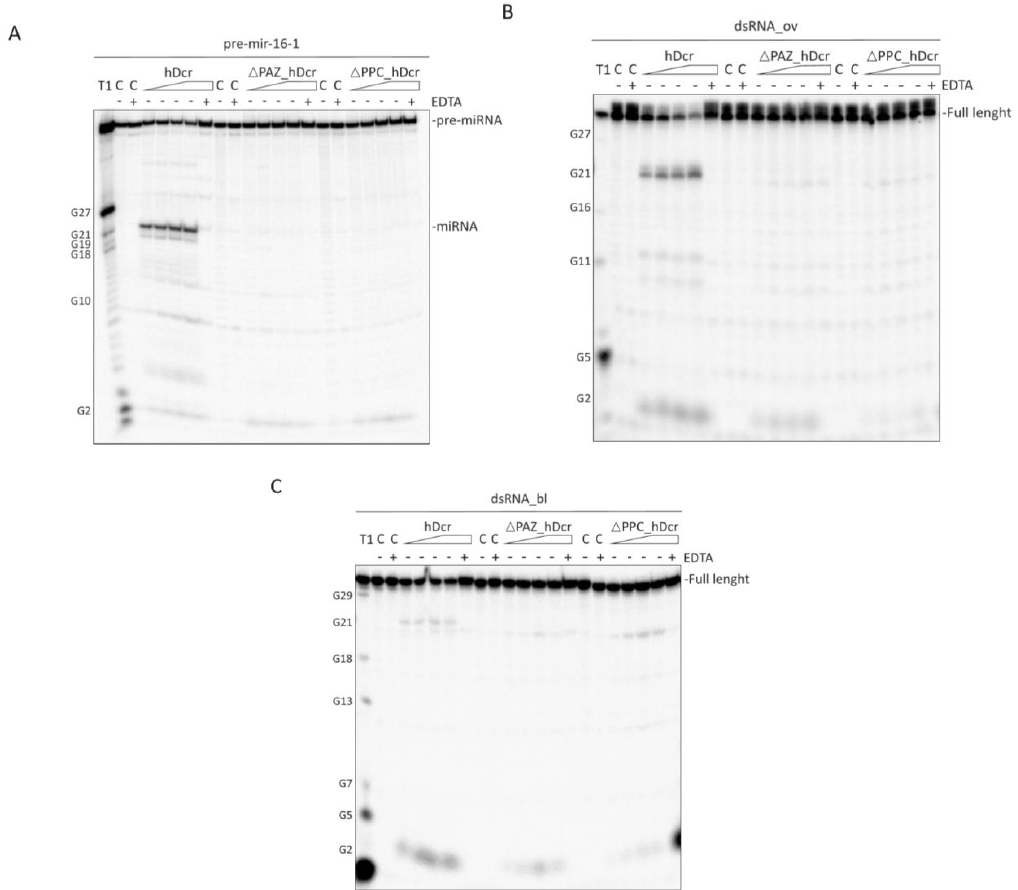
Figure 2. Comparison of the RNase activity of full-length hDicer (hDcr) and the PAZ domain deletion variants ΔPAZ_hDcr and ΔPPC_hDcr on Dicer canonical substrates. (A, B, C) The results of the RNA-cleavage assays involving: pre-mir-16-1 ( A) , 30-bp dsRNA with 2-nt 3ʹ-overhangs (B) , 30-bp blunt-ended dsRNA (C) , and increasing amounts of the respective protein (hDcr, ΔPAZ_hDcr or ΔPPC_hDcr): 12.5, 25, 50, 75 nM (represented by a triangle). ( C- ) controls incubated without a protein. ( C+EDTA ) controls incubated without a protein but with 25 mM EDTA. ( +EDTA ) supplementation of the reaction buffer with 25 mM EDTA. EDTA by chelating the Mg2+ cations present in the reaction buffer inhibits the RNase III-specific cleavage. (T1) G-ladder generated with RNase T1.